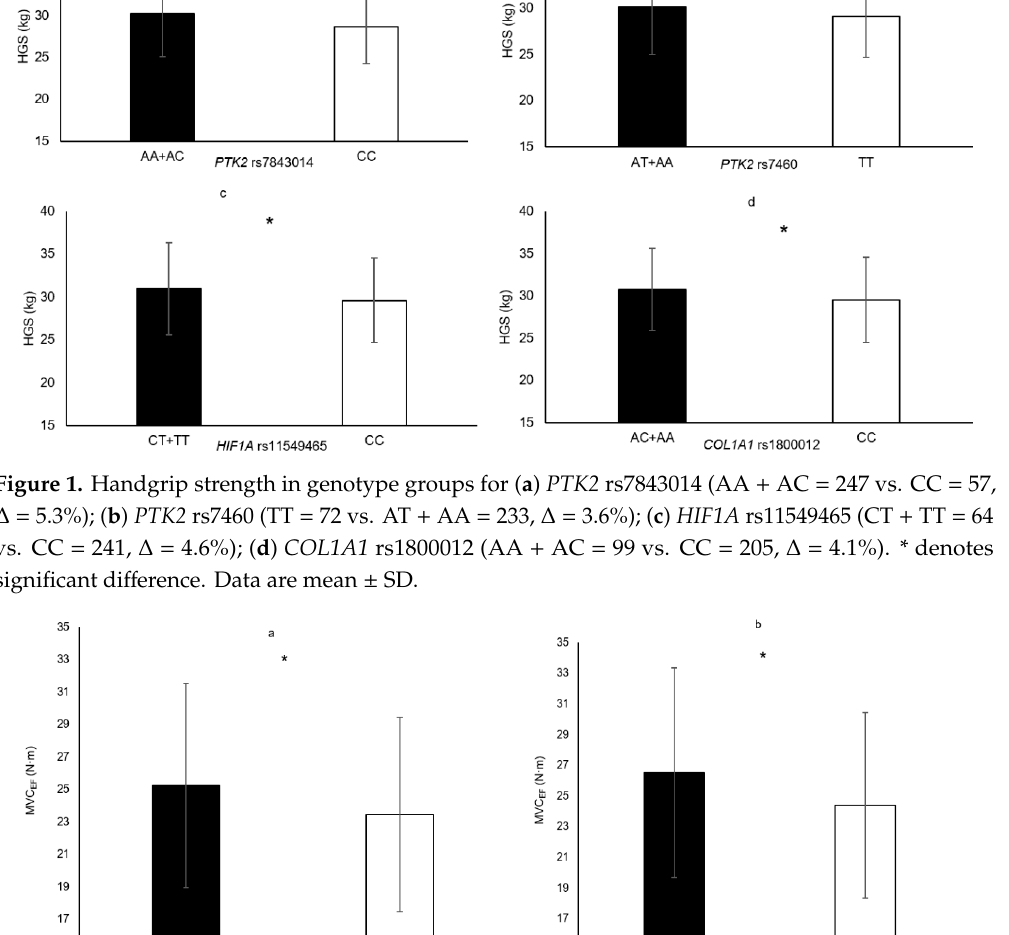
Figure 4. Biceps brachii thickness in genotype groups for ( a ) ACVR1B rs10784385 (GG = 124 vs. GT + TT = 166, Δ = 4.6%); ( b ) MSTN rs1805086 (CT = 9 vs. TT = 282, Δ = 14.7%). * denotes significant difference. Data are mean ± SD.